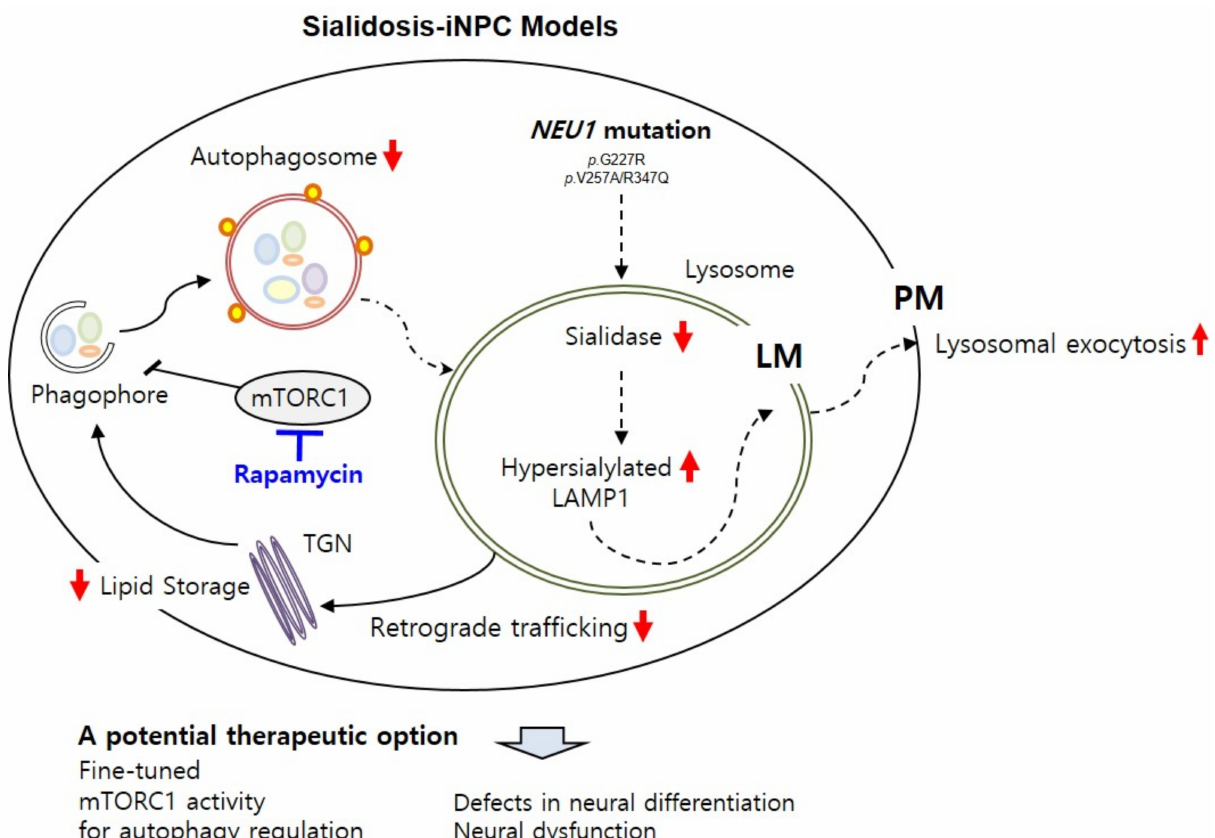
Figure 6. Schematic summary of sialidosis-specific neurological impairments characterized in sialidosis-iNPCs. The sialidosis-iNPC model reveals molecular defects in sialidosis, such as NEU1 mutation, deficient sialidase activity, and increased LAMP1 expression. Deficient NEU1 enzyme activity caused by genetic mutations in the NEU1 gene results in impaired autophagy and lysosomal pathways in sialidosis-iNPCs. Induction of autophagy by rapamycin effectively rescues sialidosis-related defects in sialidosis-iNPCs, suggesting an important role of the autophagy–lysosome pathway in neurological abnormalities associated with